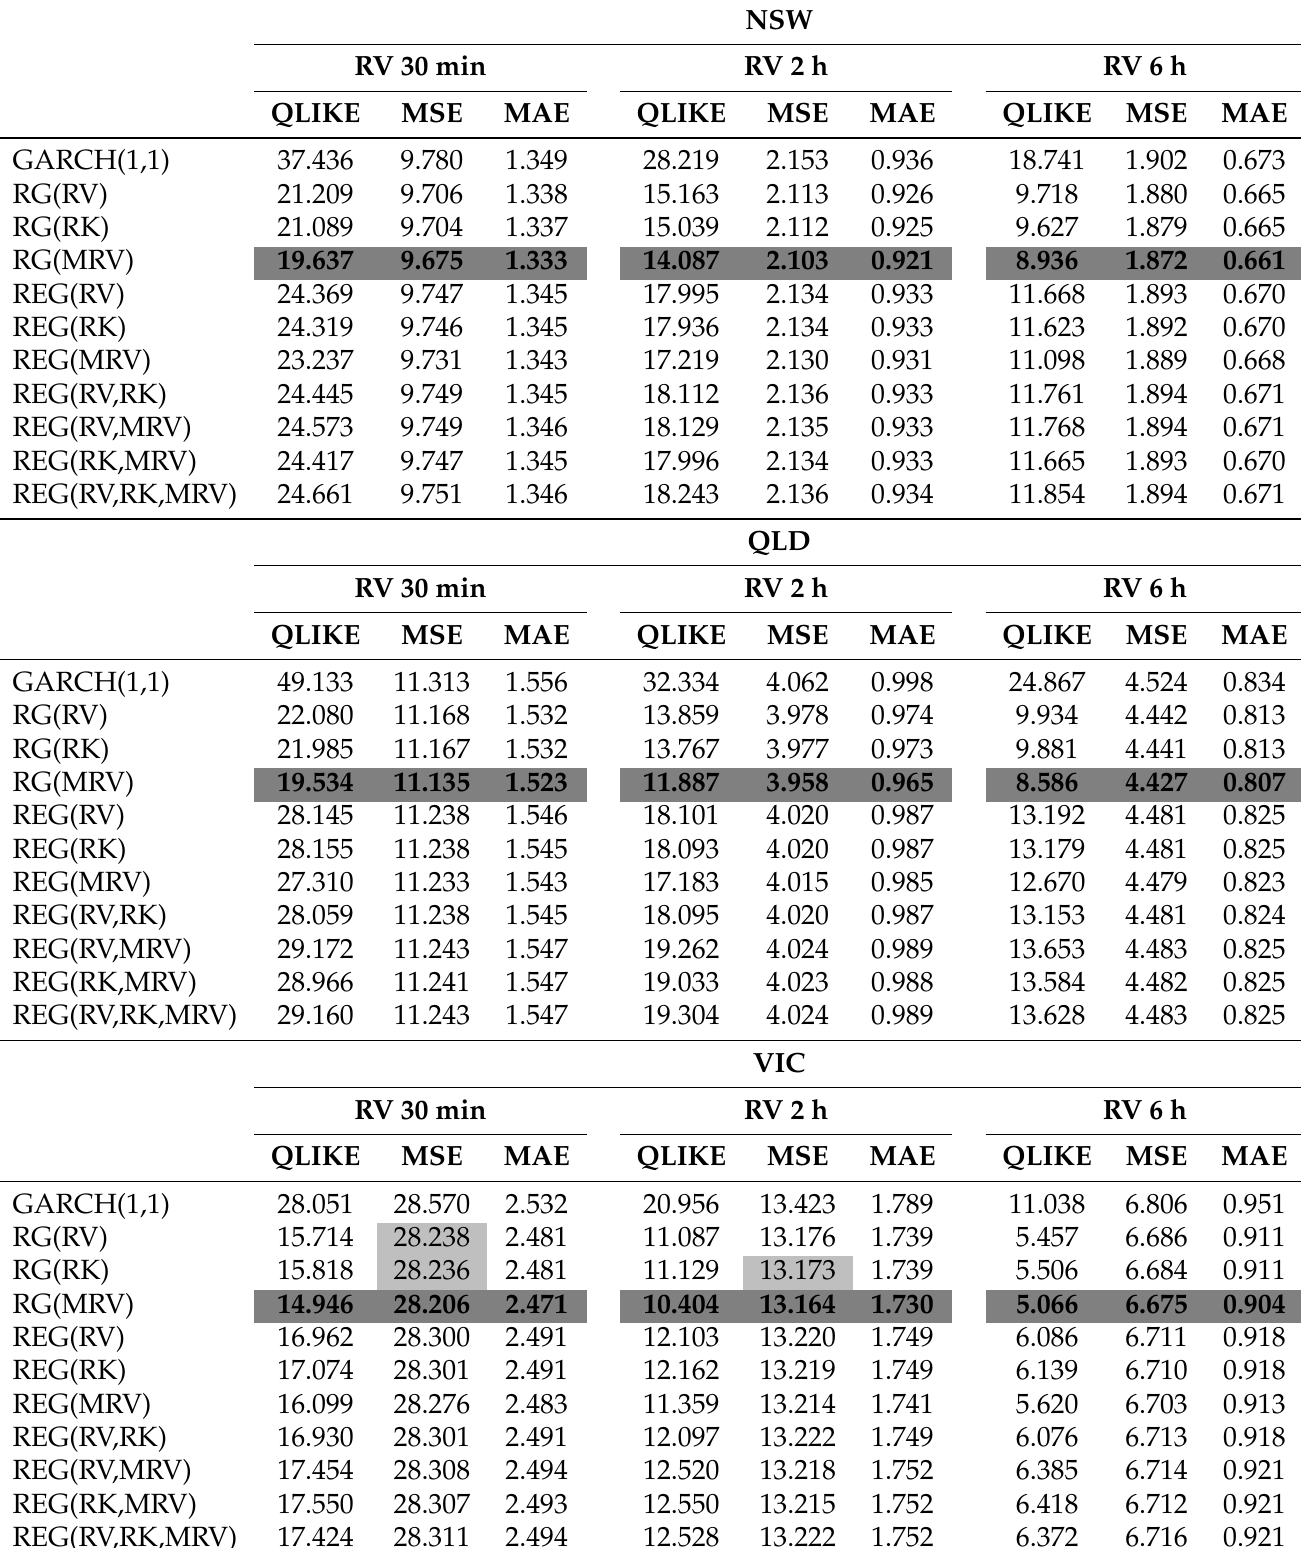
Table 5. Out-of-sample loss functions comparison: QLIKE, MSE, and